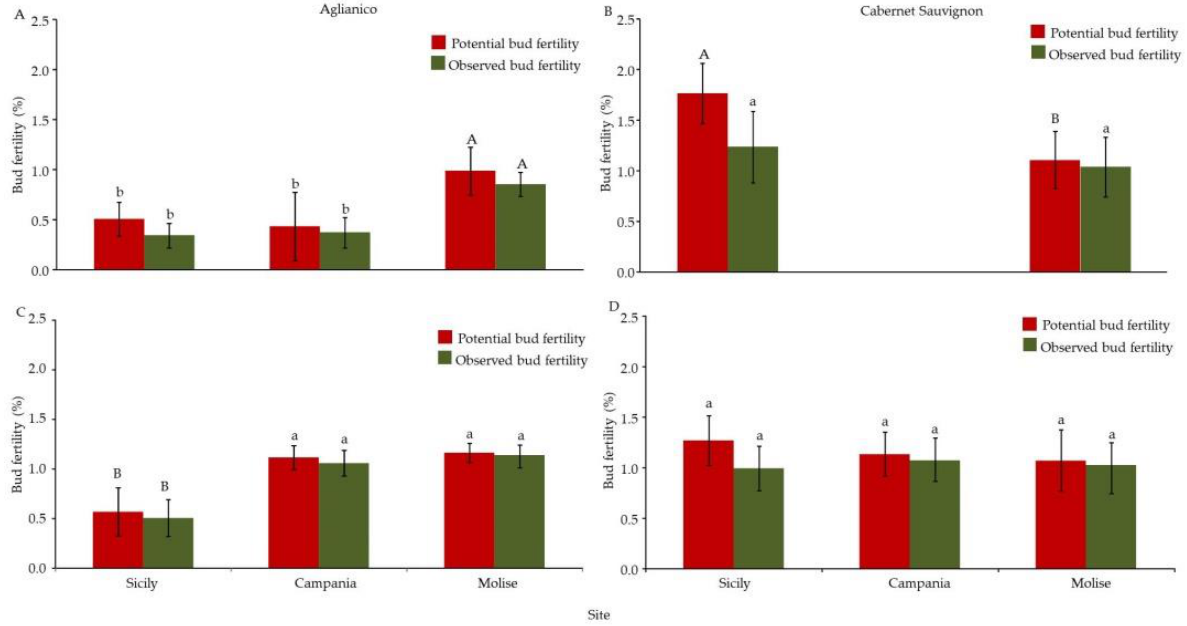
Figure 2. Potential and observed bud fertilities recorded in two cultivars, Aglianico (AGL) and Cabernet Sauvignon (CAB), grown in three different sites, Molise (MOL), Campania (CAM), and Sicily (SIC), over two years ( A ): Aglianico 2020; ( C ): Aglianico 2021; ( B ): Cabernet Sauvignon 2021; ( D ): Cabernet Sauvignon 2021). Measurements were made when all inflorescences were fully developed (Biologische Bundesanstalt, Bundessortenamt and CHemical industry: inflorescence 57). Mean values for each parameter, indicated by different letters, are significantly different (lowercase letter p ≤ 0.05, uppercase letter p ≤ 0.001, bars indicate one standard deviation), based on Tukey’s HSD test within years and cultivars.